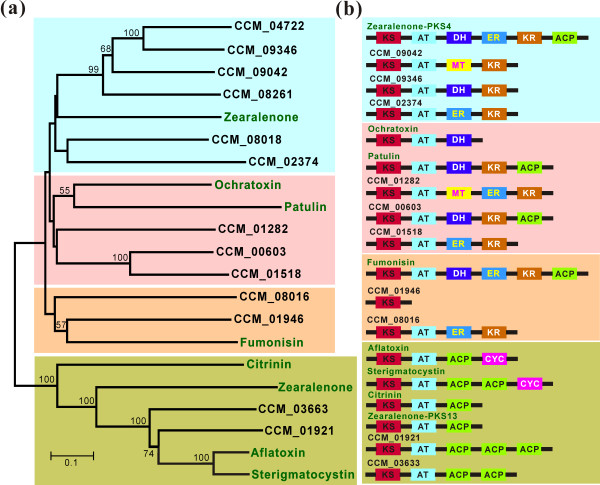
Phylogenetic and modular analysis of C. militaris polyketide synthases compared with those involved in the production of human mycotoxins. (a) A neighbor-joining tree showing the relationships of ketoacyl CoA synthase (KS) domain sequences. (b) Modulation and comparison of C. militaris PKSs with those involved in production of mycotoxins. The PKS-NRPS hybrid proteins CCM_04722, CCM_08261 and CCM_08018 are not included in the analysis. Domain definitions: ACP, acyl carrier protein domain; AT, acyltransferase domain; CYC, cyclase domain; DH, dehydratase domain; ER, enoyl reductase domain; KR, ketoreductase domain; MT, methyltransferase domain; TE, thioesterase domain. The accessions and references for different mycotoxins are provided in the Materials and methods.